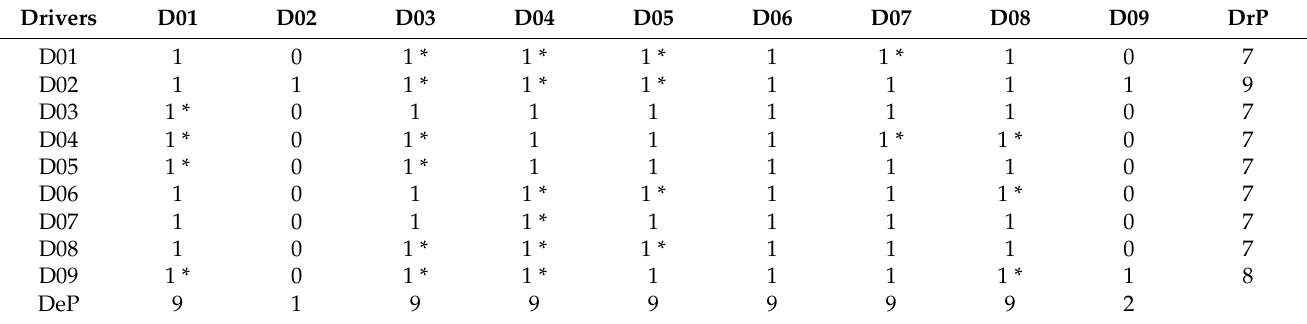
Table 4. Final reachability